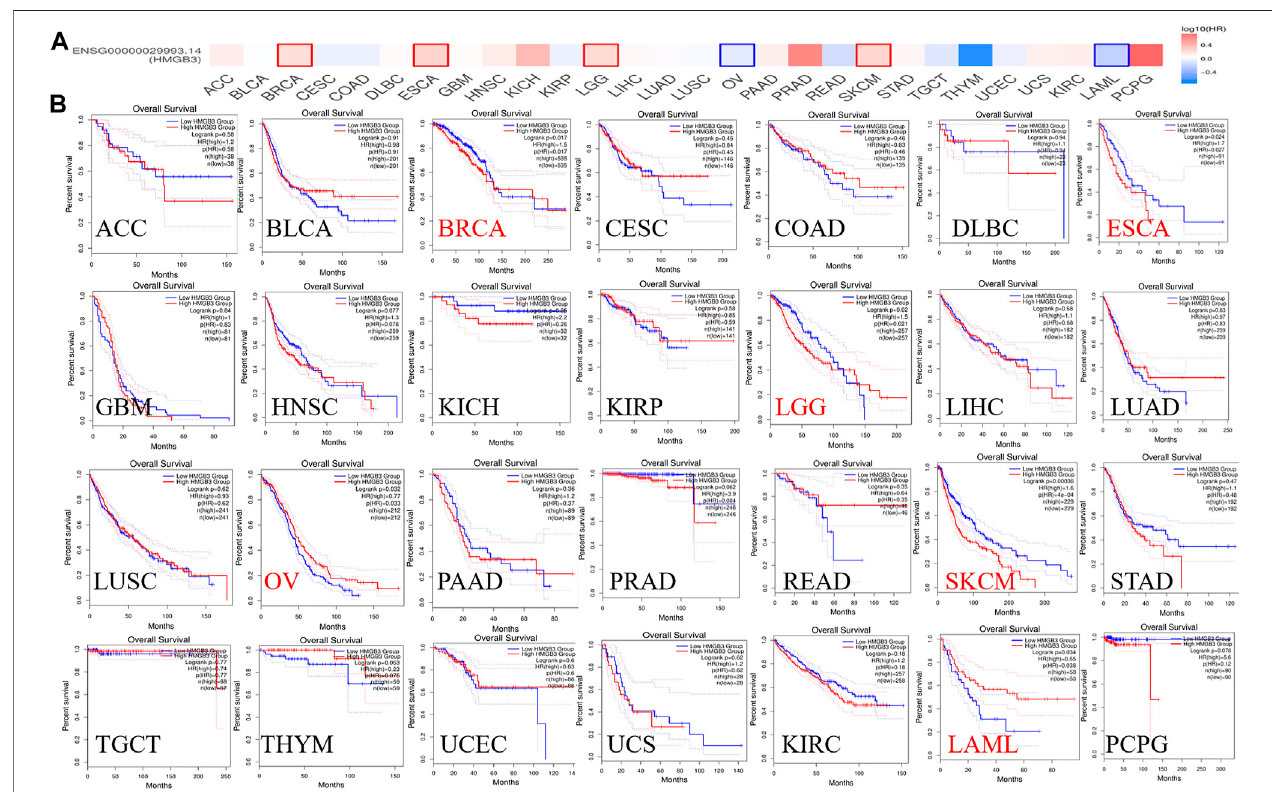
FIGURE 5 | The correlation between HMGB3 gene and OS in tumors. (A) Survival map in HMGB4 abnormally expressed tumors; (B) OS data in HMGB3 tumors, logrank p > 0.05.